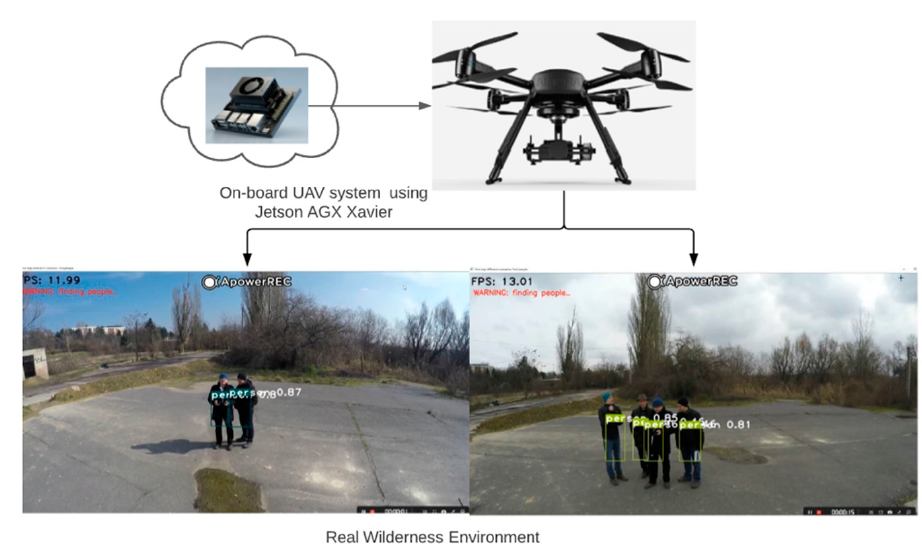
Figure 1. Practical application of an on-board unmanned aerial vehicles (UAV) with Jetson Xavier GPU for rescue.